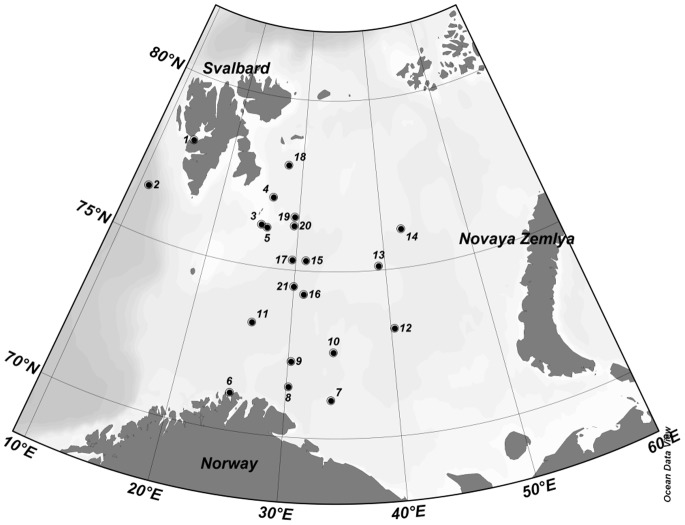
The study area with experimental station locations (corresponding to Table 1).